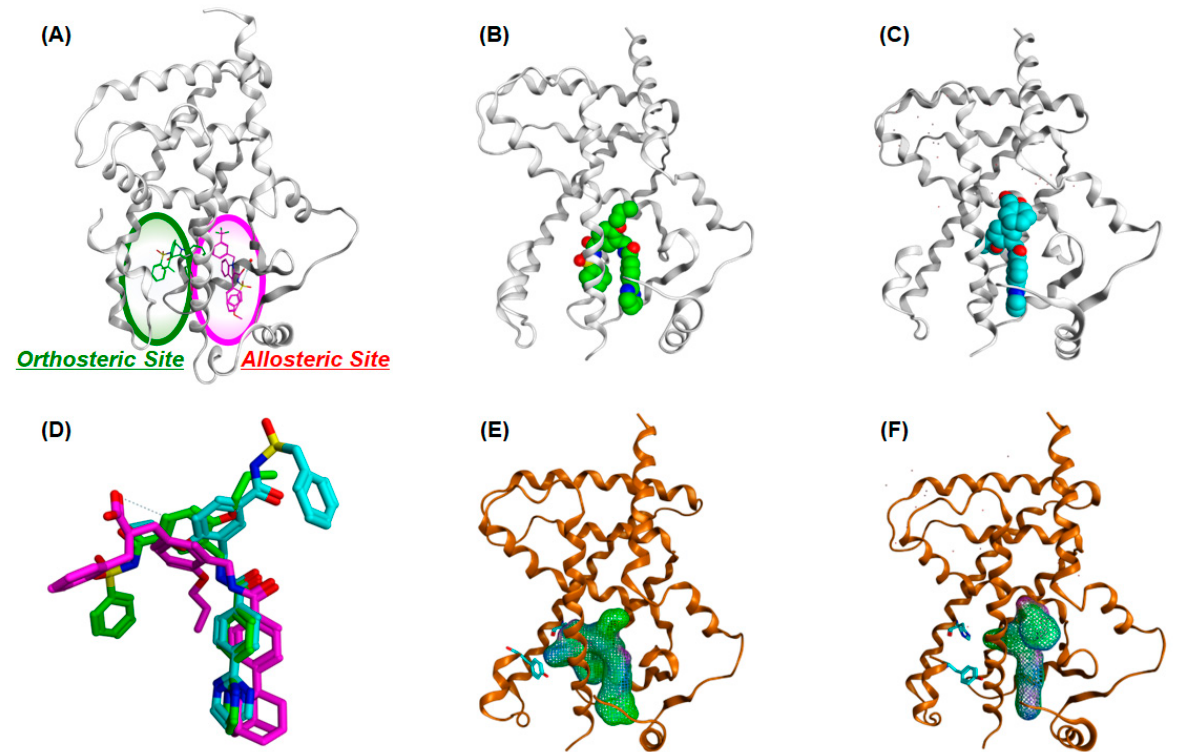
Figure 5. The binding mode differences between MEKT ‐ 75 and MEKT ‐ 76. ( A ) Co ‐ crystal structure of NSI ‐ bound hPPAR γ (PDB 2HFP) shows two bound carboxamide molecules, one bound to the orthosteric site (green) and the second bound to the allosteric site (magenta). ( B ) Whole structure of the non ‐ full agonist form of PPAR γ LBD–MEKT ‐ 75. Proteins are represented as a van der Waals surface model and MEKT ‐ 75 is depicted as a green van der Waals model. ( C ) Whole structure of the non ‐ full agonist form of PPAR γ LBD–MEKT ‐ 76. Proteins are represented as a van der Waals surface model and MEKT ‐ 75 is depicted as a cyan van der Waals model. ( D ) Zoomed ‐ in view of the entrance region of the PPAR γ LBD–MMT ‐ 160 complex. ( E ) Whole structure of the non ‐ full agonist form of PPAR γ LBD–MEKT ‐ 75. Proteins are represented as a van der Waals surface model and the surface area of MEKT ‐ 75 is depicted. ( F ) Whole structure of the non ‐ full agonist form of PPAR γ LBD–MEKT ‐ 76. Proteins are represented as a van der Waals surface model and the surface area of MEKT ‐ 76 is depicted.